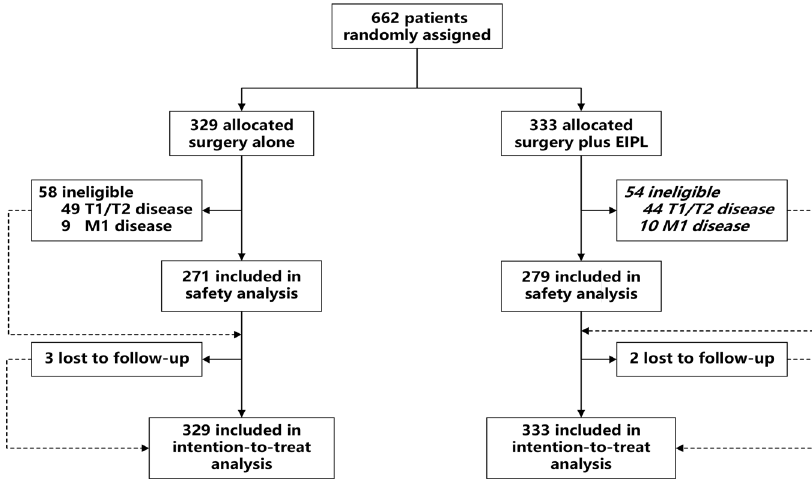
Fig. 1 Trial CONSORT fl ow diagram. EIPL extensive intraoperative peritoneal